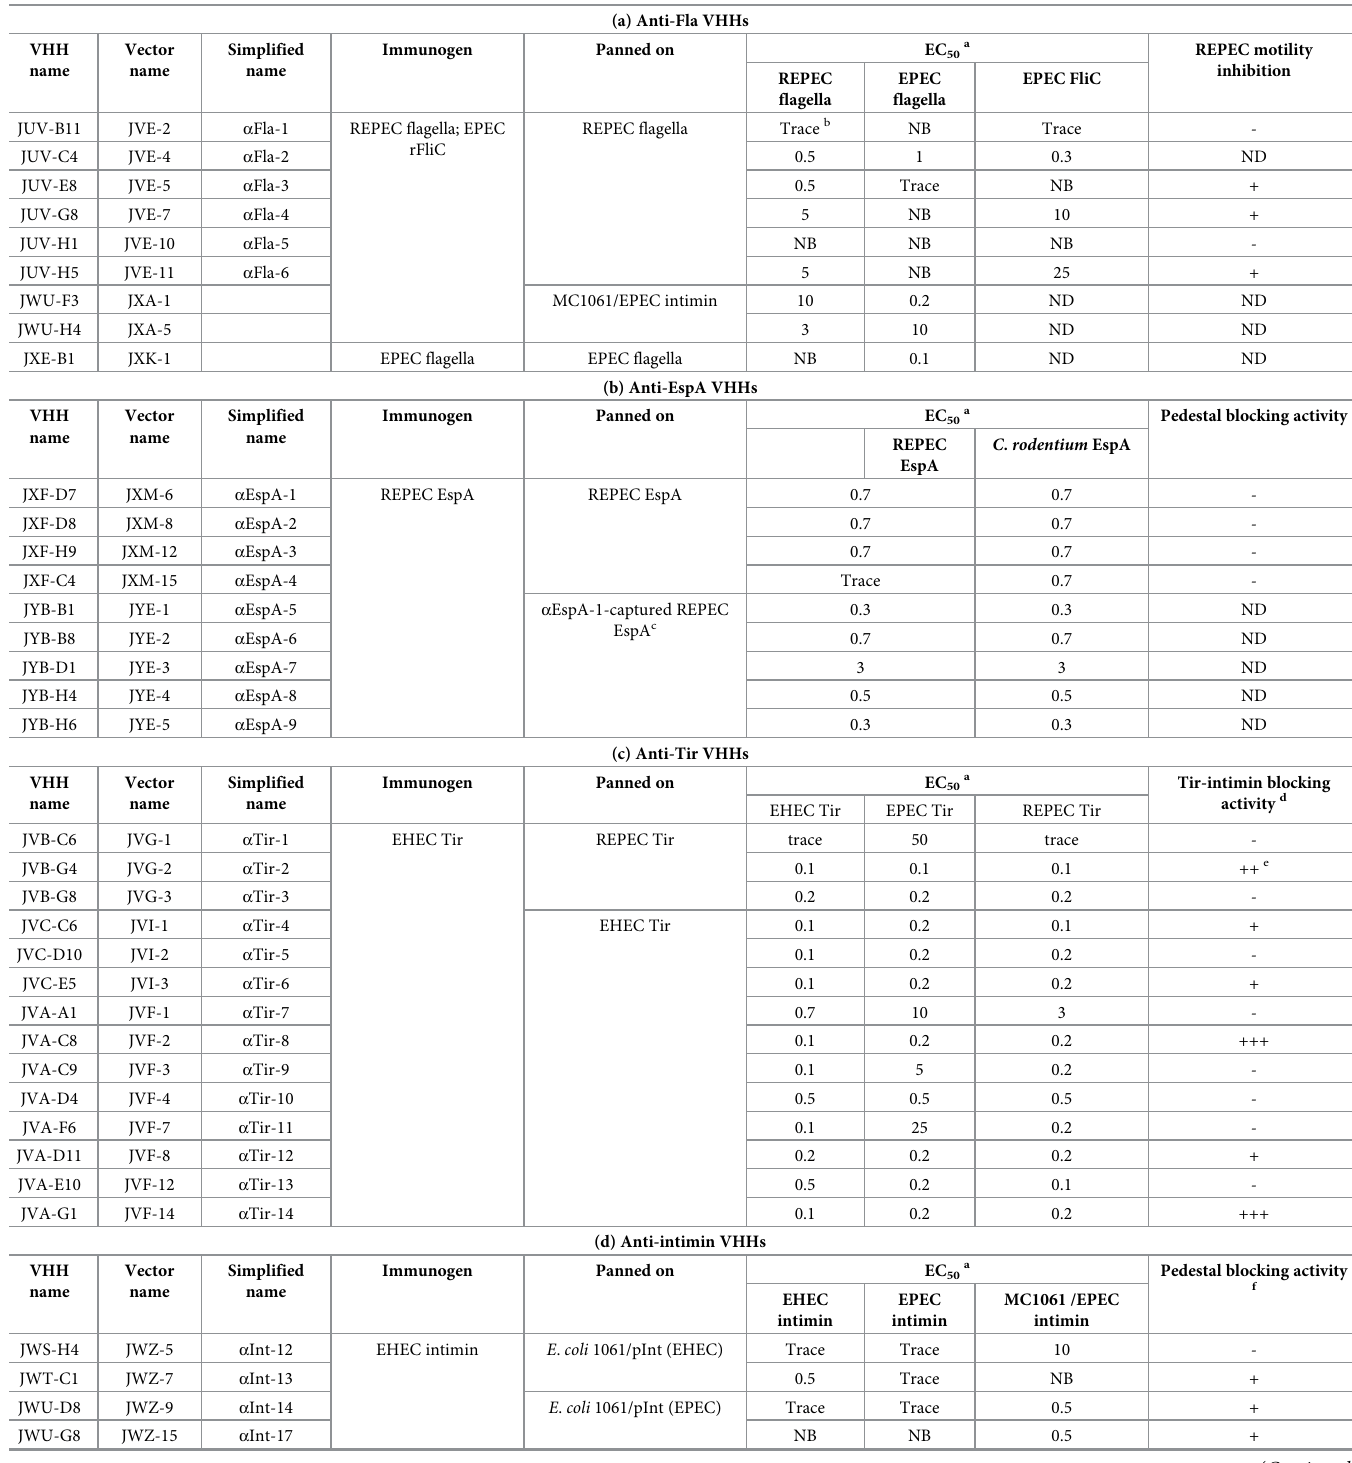
Table 1. Selected